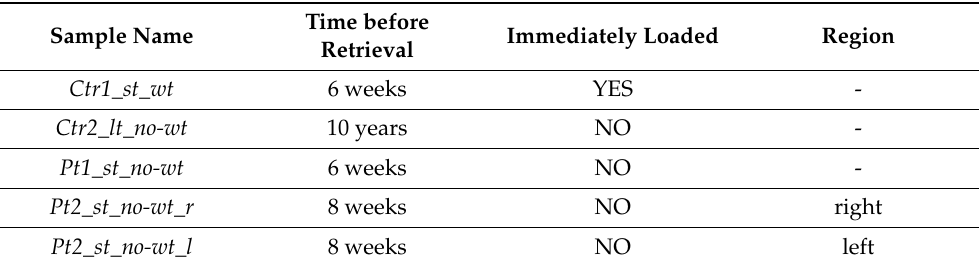
Table 1. Description of the investigated samples. Ctr1_st_wt : immediately loaded and retrieved after 6 weeks ( st: short time; wt: immediately loaded). This specimen had already been studied [9,12]. Ctr2_lt_no-wt: the abutment was inserted subgingivally, healed without loading for 6 months and then placed on the surface with the healing screw; the final prosthesis was made after another 3 months, with a total of 9 months before applying the masticatory load ( lt: long time; no-wt: not immediately loaded). Pt1_st_no-wt: patient test 1—not loaded and retrieved after 6 weeks. Pt2_st_no-wt_r: patient test 2—not loaded and retrieved after 8 weeks. Right side of the jaw ( r ); Pt2_st_no-wt_l: patient test 2—not loaded and retrieved after 8 weeks. Left side of the jaw ( l